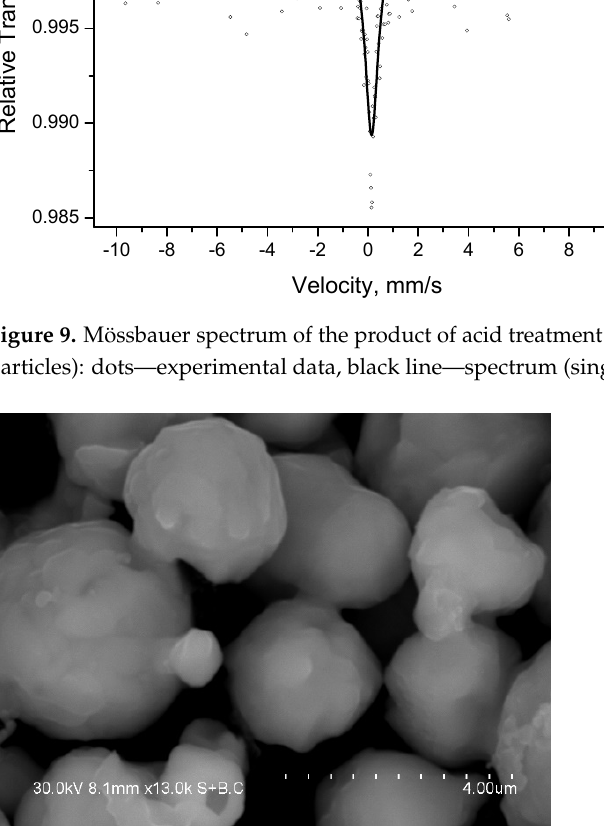
Figure 10. Morphology of the powder alloy obtained by annealing of the Fe@Pd core–shell particles.